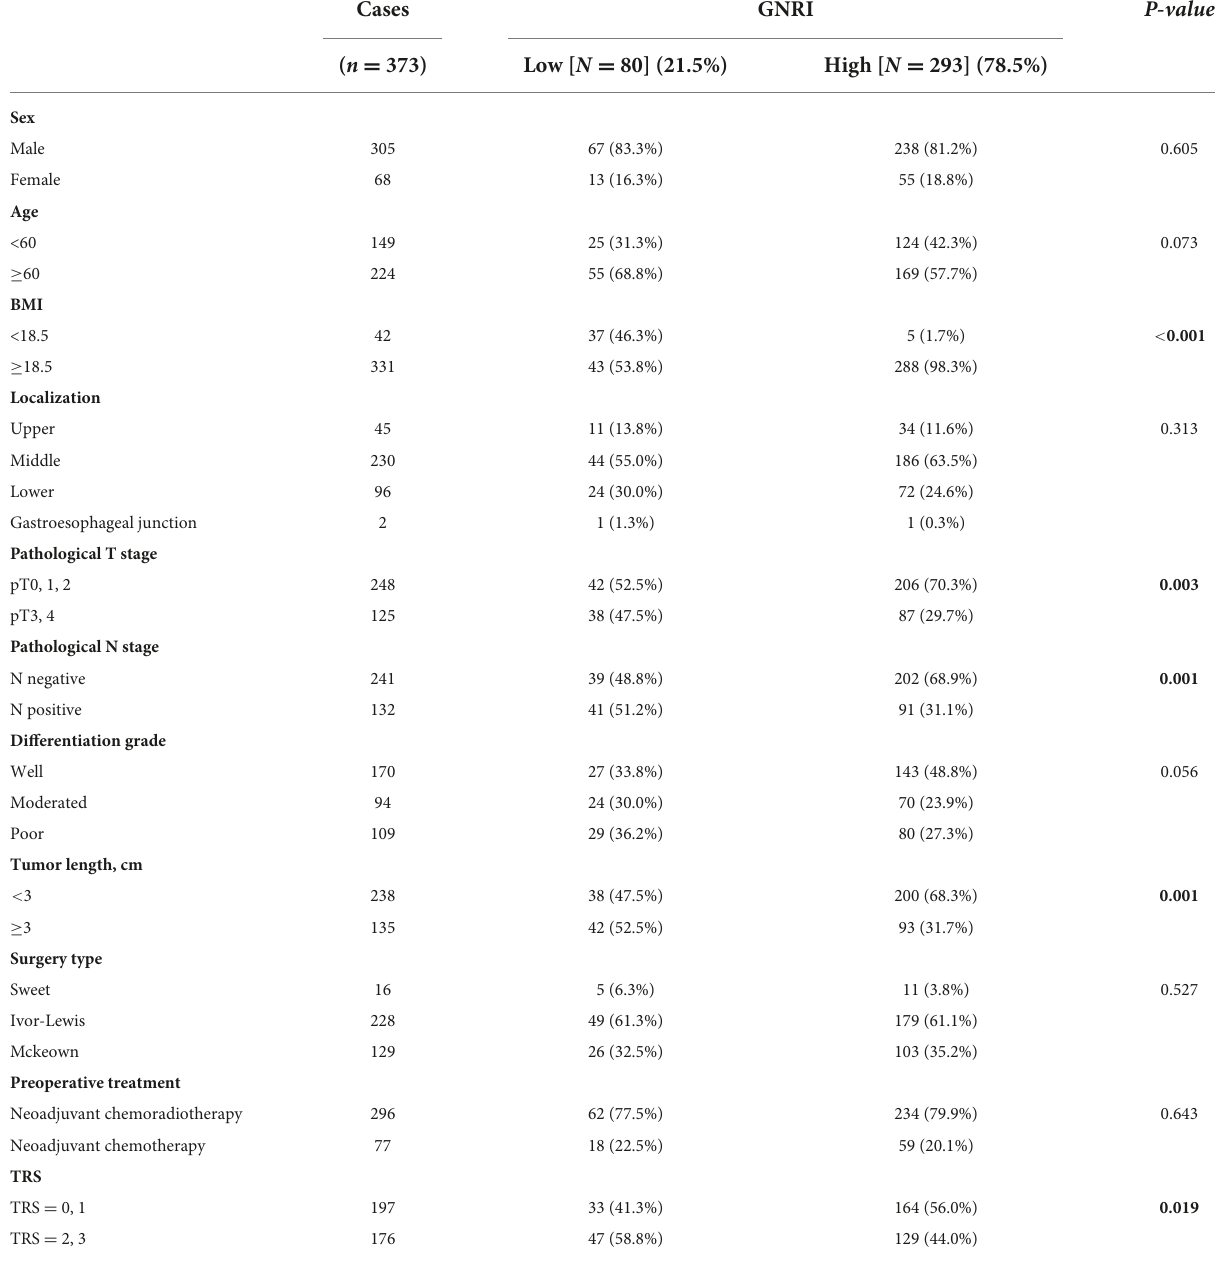
TABLE 1 Patient characteristics and geriatric nutritional index